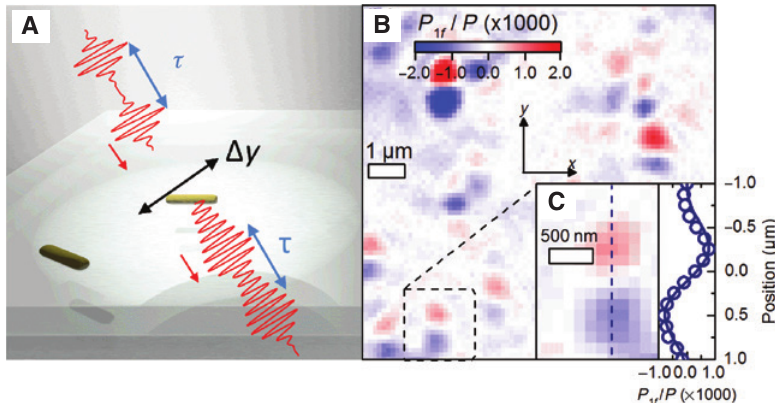
Figure 2: Schematic of the FT-SMS set-up and 2D map of the experiment. (A) A phase-locked pair of linearly polarized ultra-broadband pulses, separated by a time delay τ , is focused onto the surface of a glass substrate that is covered with single gold nanorods. The position of the nanorods is periodically modulated in the y -direction and the trans- mitted and scattered light is collected in the far field. (B) The normalized map of P / P recorded while scanning the nanorod sample through 1 f is retrieved by demodulating the transmitted power P at the modulation frequency 1 f . The light scattering from the laser focus. The power P 1 f a single nanorod appears as a dipolar pattern with positive and negative values of P / P , oriented along the modulation axis y. Inset: The 1 f magnified map of a single nanorod. (C) Cross section (circles) taken along the dashed line in the inset. The solid line shows the expected line shape, given as the derivative of the Bessel-like intensity distribution of the